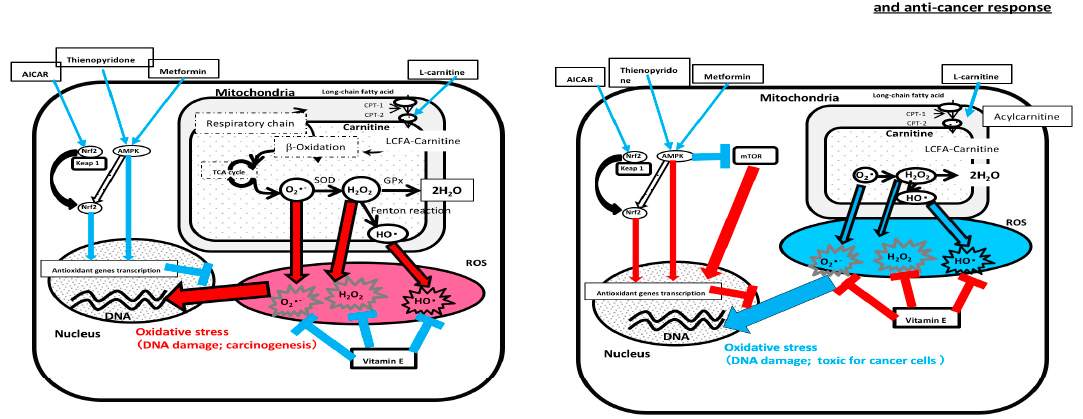
Figure 1. Oxidative stress and anti-oxidant in non-alcoholic steatohepatitis (NASH) and liver cancer. Red lines; unfavorable effects, Blue lines; favorable effects, AICAR, 5-aminoimidazole-4- carboxamide-1- β - D -ribofuranoside; Nrf2, nuclear factor erythroid 2-related factor; AMPK, AMP-activated protein kinase; Keap1, Kelch-like enoyl-CoA hydratase (ECH) associated protein; Nrf2, nuclear factor erythroid 2-related factor; CPT, carnitine palmitoyltransferase; SOD, superoxide dismutase; GPx, glutathione peroxidase; LCFA-carnitine, long-chain acylcarnitine; TCA-cycle, tricarboxylic acid